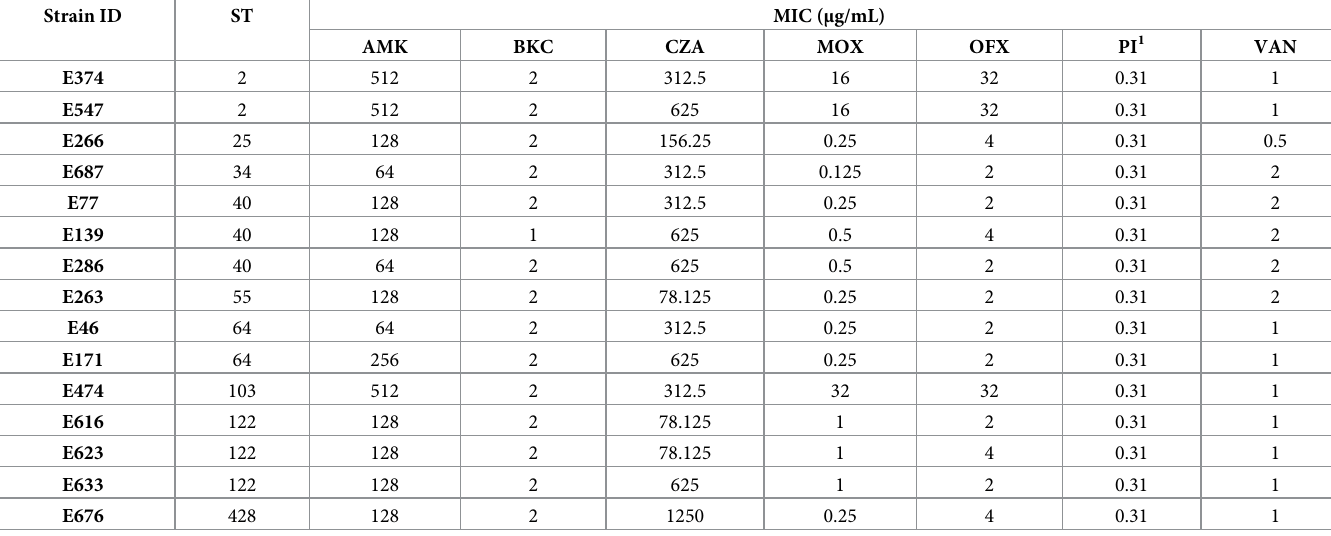
Table 1. Minimum Inhibitory concentration (MIC) profiles of E . faecalis endophthalmitis isolates. Strain